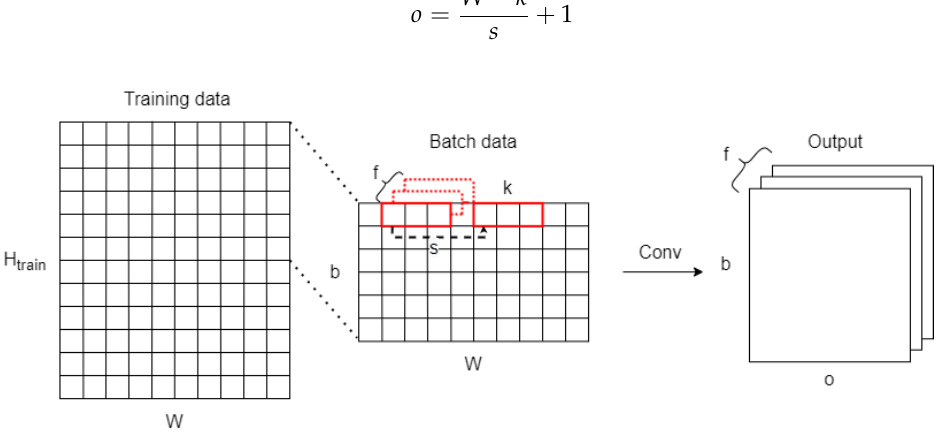
Figure 3. Scheme for CNN